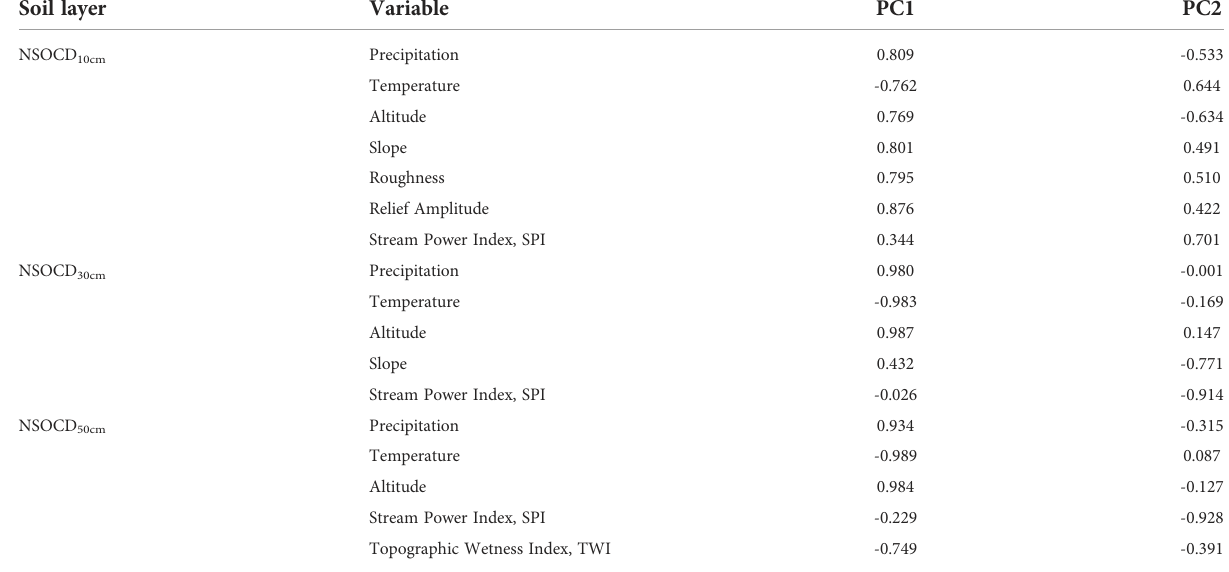
TABLE 3 Scoring coef fi cients of principal components.